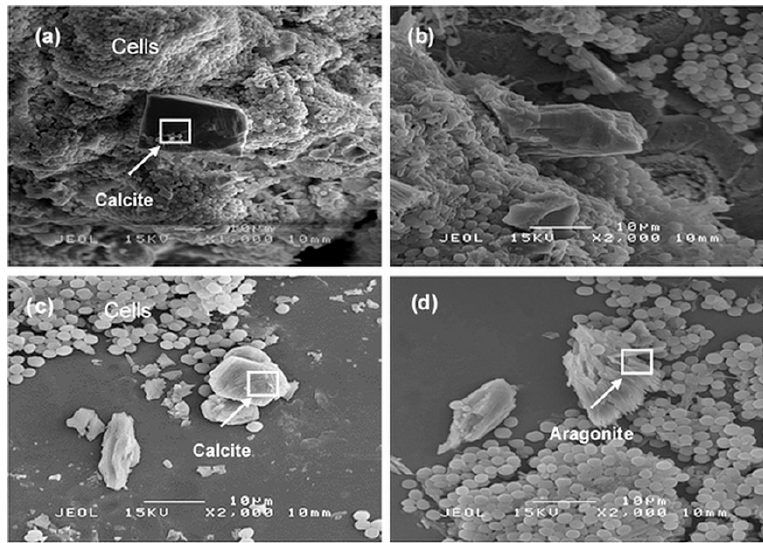
Figure 5. SEM images of CaCO 3 crystals formed by C . vulgaris ( a ) rhombohedric calcite crystal protruding from masses of cells at 1000× magnification, ( b ) side view of crystal protrusion for masses of cells at 2000× magnification, ( c ) free-floating calcite crystals at 2000× magnification, and ( d ) needle-like crystals possibly aragonite at 2000× magnification.